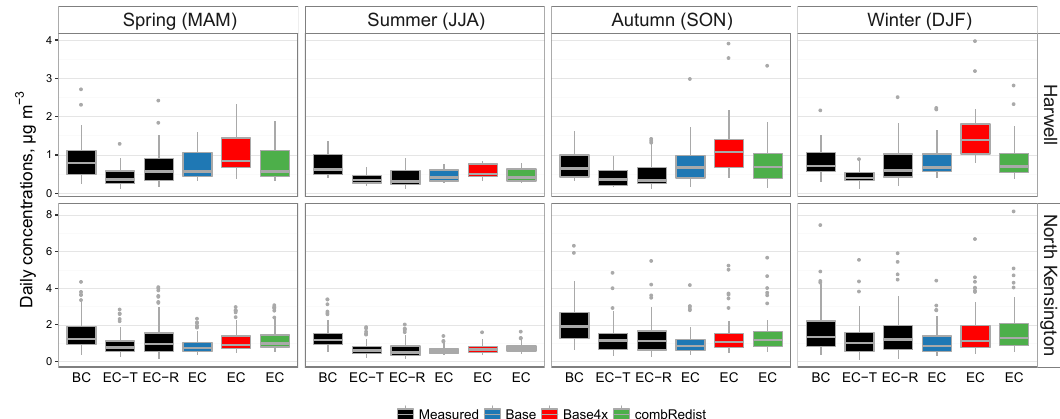
Figure 13. Seasonal box plots of daily average concentrations of measured BC, EC-T, EC-R, and modelled EC concentrations at Harwell, and London North Kensington, measurement sites that measure both BC and EC, year 2012. Middle line: median, boxes: 25th and 75th quartiles (i.e. the interquartile range – IQR), whiskers extend to 1 . 5 × IQR, and all daily values beyond the whiskers are plotted